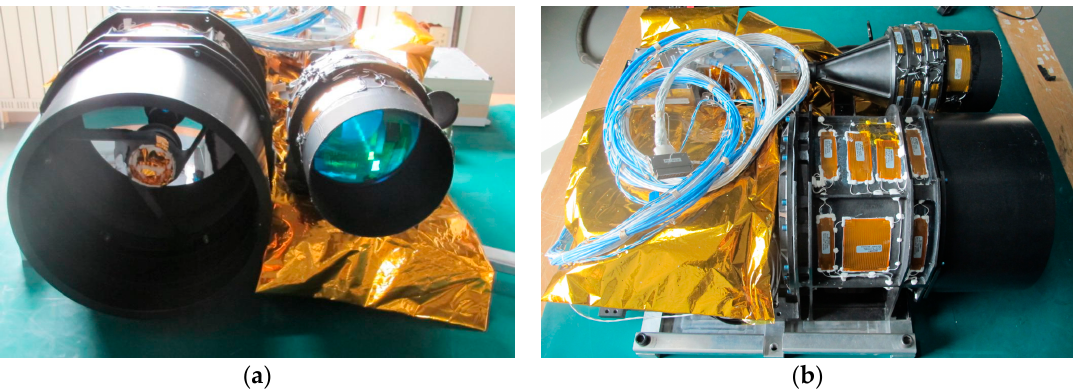
Figure 2. The spare one of the ZY3-02 laser altimeter: ( a ) the front of the laser altimeter; and ( b ) the top of the laser altimeter. Table 1. The fundamental design specification and characteristics of ZY3-02 laser altimeter.